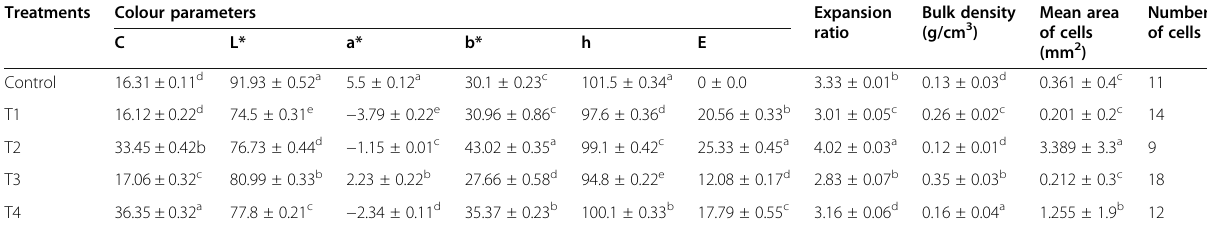
L*: lightness; a*: red-green balance; b*: yellow-blue balance; Δ E: total colour chance index, h : Hue angle and Δ E: Total colour difference, a-c: indicated with similar letters in columns do not differ significantly at p =0.05. T1, T2, T3 and T4: extruded corn product fortified with 3% (w/w) of laurel, turmeric, ginger and mixture formula contains 3% of the three herbs ’ mixture mentioned (1:1:1),